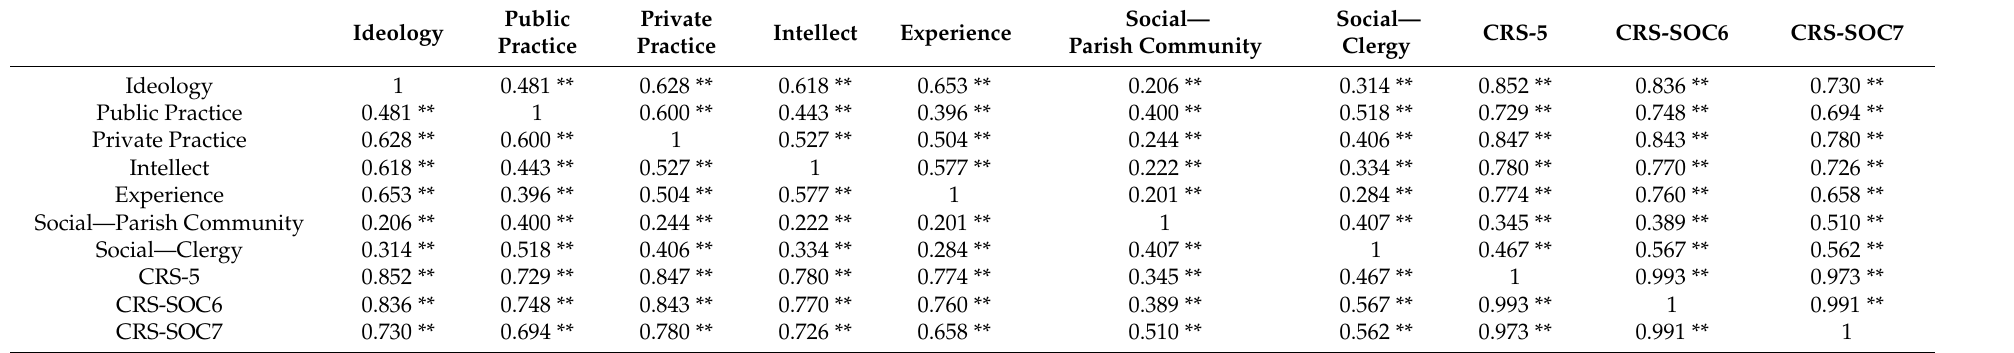
Table 5. Pearson correlations between the CRS-SOC items and total centrality scores: Online survey—General population sample. Public Private Social— Social— Ideology Intellect Experience Parish Community